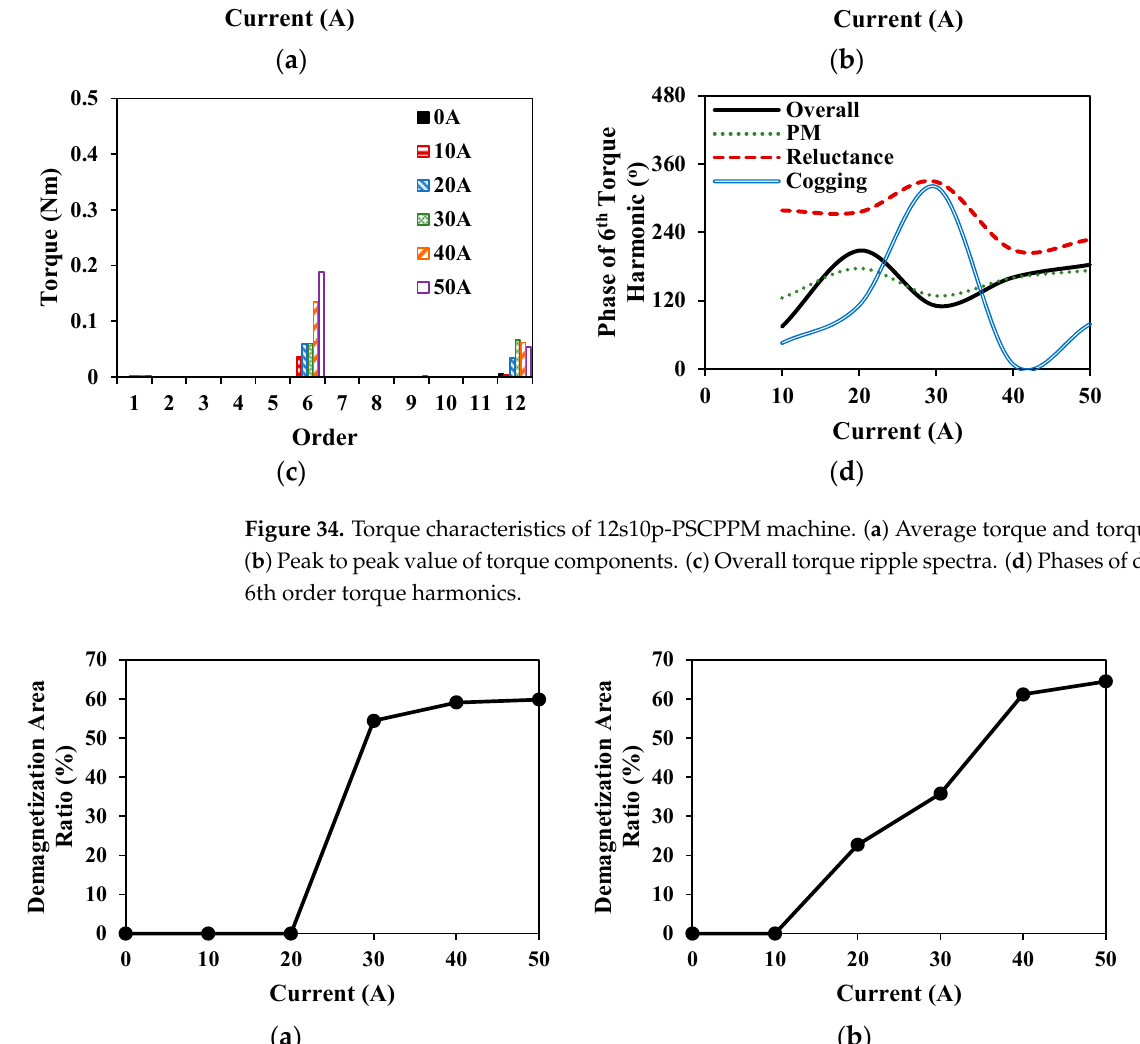
Figure 35. Demagnetization area ratios negative d-axis current. ( a ) 12s8p-PSCPPM. ( b ) 12s10p- PSCPPM.